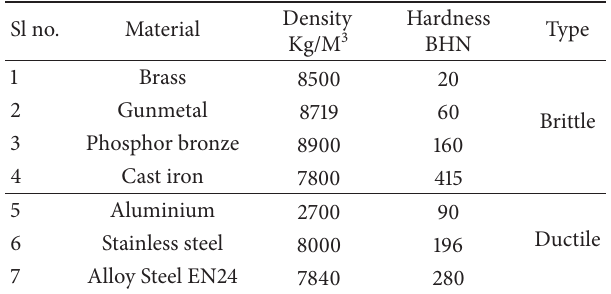
Table 2: Defining properties on machinability of materials. Sl